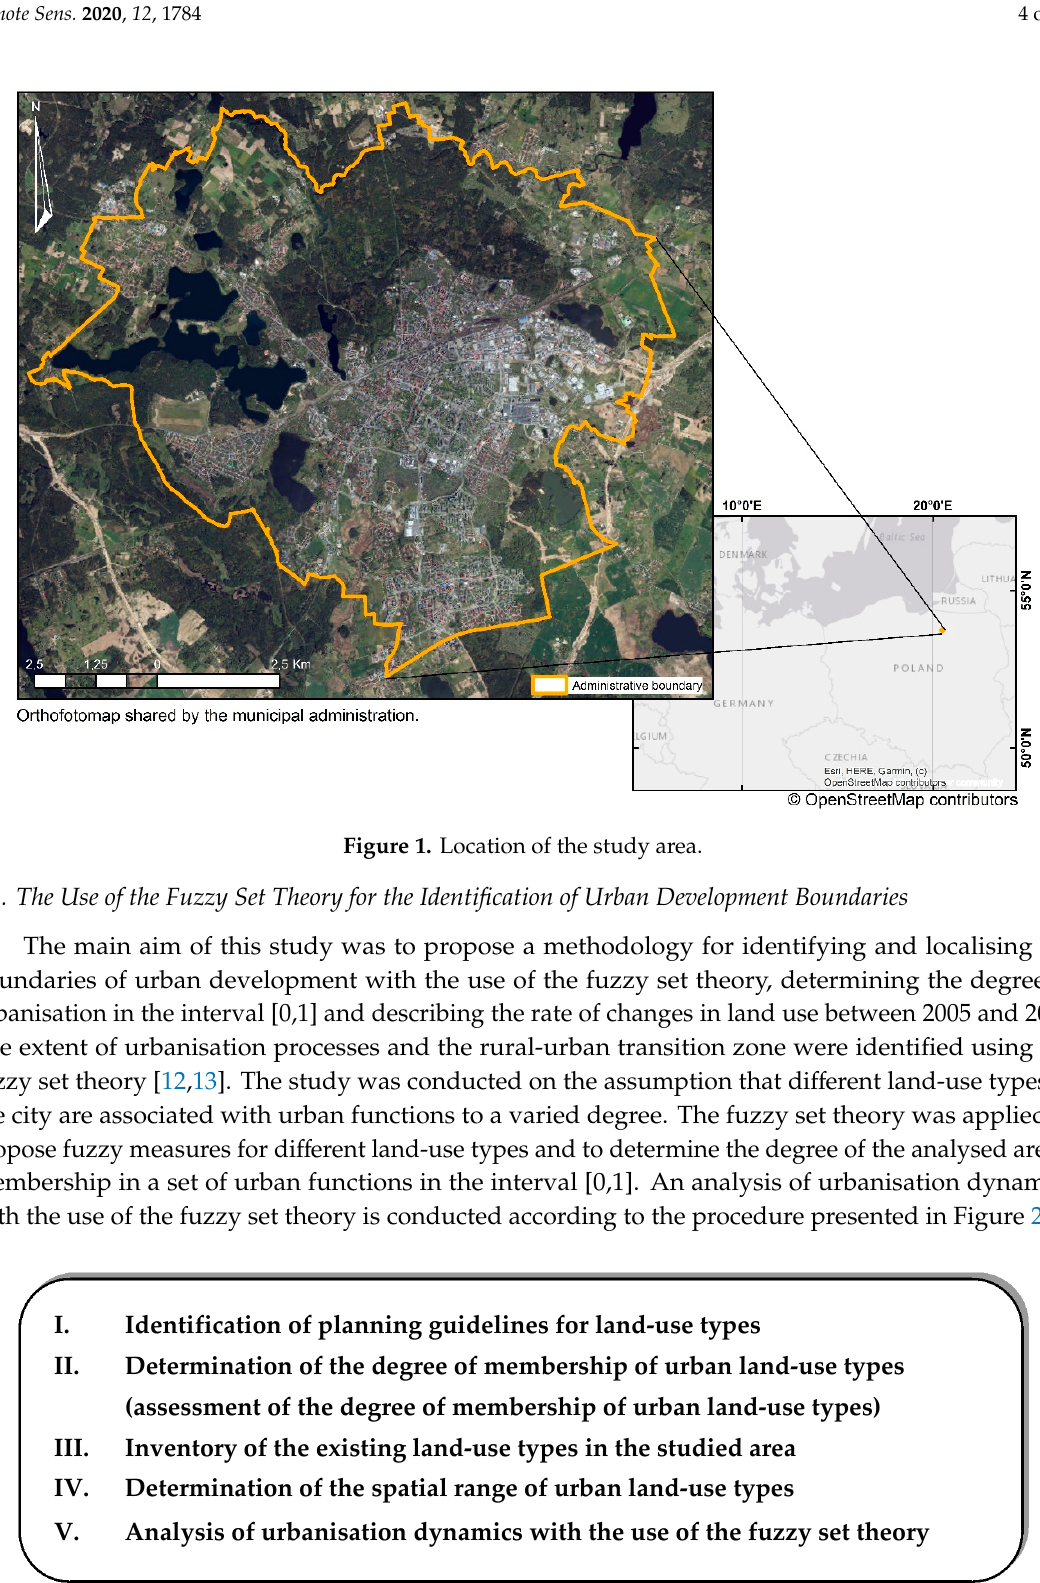
Figure 2. Procedure for the analysis of urbanisation dynamics with the use of the fuzzy set theory.